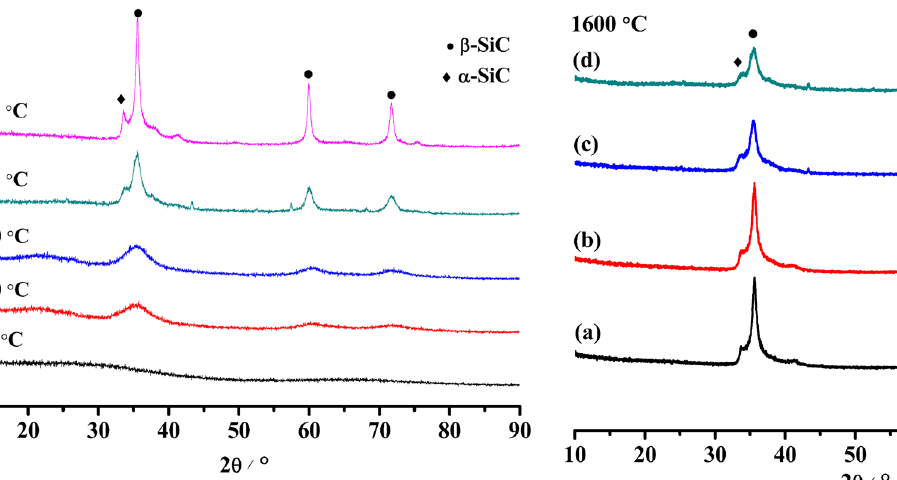
Figure 9: XRD patterns of PACS - 5 - derived ceramics at di ff erent temperatures.